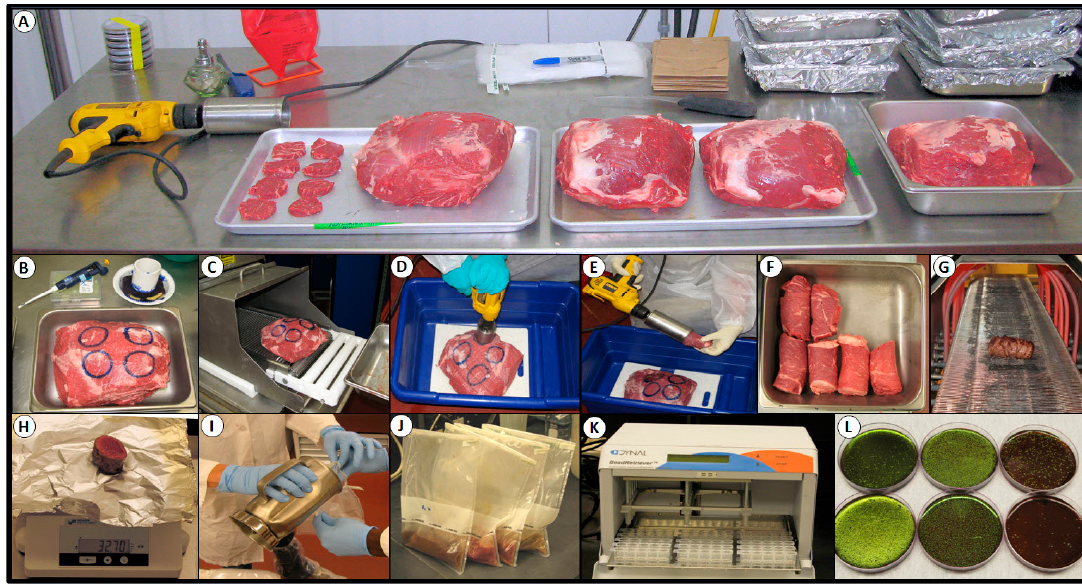
Figure 2. Phase 2, evaluation of select antimicrobials against E. coli O157:H7-inoculated beef subprimals in conjunction with blade tenderization. ( a ) Array of beef subprimals during one trial; ( b ) beef subprimal prepared for inoculation in labeled zones; ( c ) inoculated beef subprimal entering blade tenderizer; ( d ) sprayed and blade-tenderized subprimal being cored; ( e ) recovery of beef cores using a two-inch circular drill bit; ( f ) recovered beef cores; ( g ) sanitizing outside of beef cores by passage through radiant heat oven; ( h ) sectioning of beef cores; ( i ) blending and ( j ) enrichment incubation of beef sections; ( k ) Bead Retriever TM for immunomagnetic bead recovery and enrichment of E. coli O157:H7 from enrichment broth; ( l ) plating of immunomagnetic beads with recovered E. coli O157:H7 onto EMB media containing rifamycin SV.